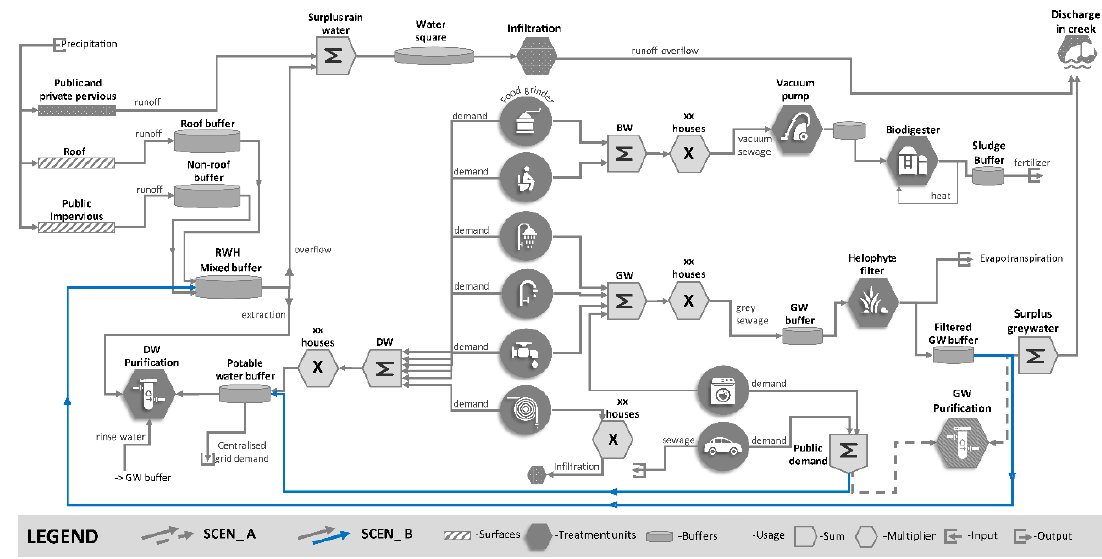
Figure 4. The urban water cycle map of SUPERLOCAL in the signal language of UWOT.